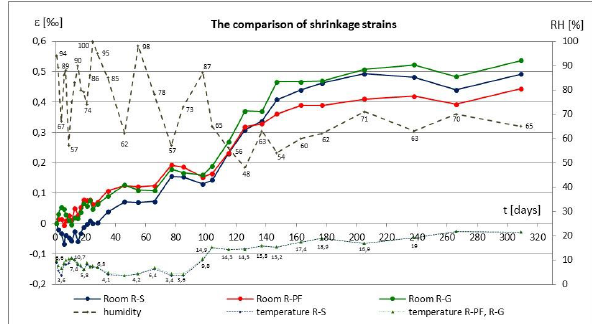
Figure 5: Graphs of average strain increases on the screed surface in individual rooms together with graphs of humidity and tempera- ture changes